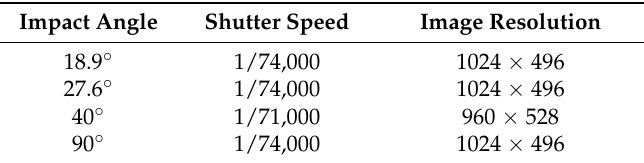
Table 1. Camera settings for each impact angle.